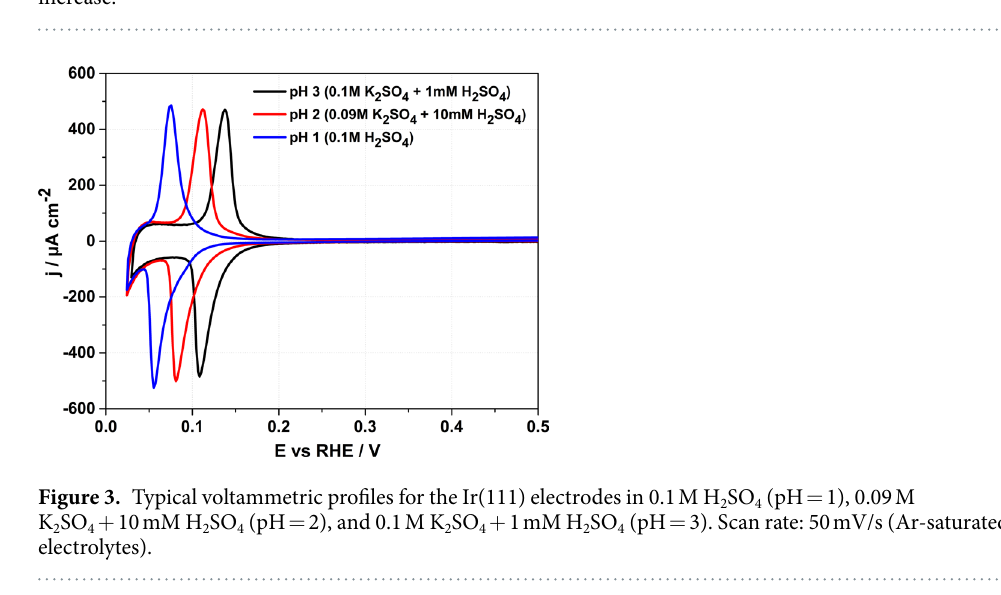
Figure 2. Anodic parts of the voltammograms presented in Fig. 1 (H-upd region) for the electrolytes with the pH values from 1 to 5. The arrow shows the increase of the current of the peak at ~0.25 V vs RHE with the pH increase.